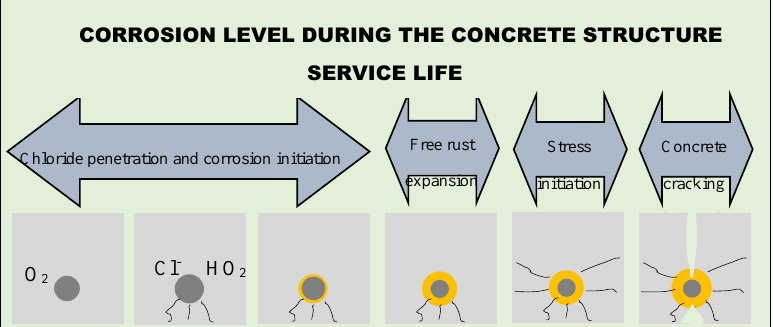
Figure 1. Schematic illustration of the various steps of the concrete deterioration due to the corrosion of the reinforcement (adapted from [3]).